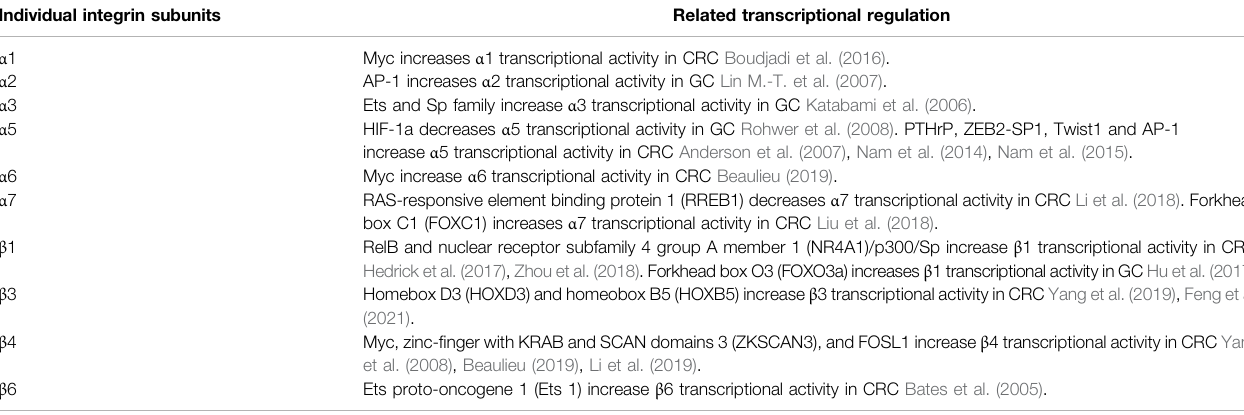
TABLE 2 | Transcription factors involved in the regulation of integrin subunits in GC and CRC. Individual integrin subunits Related transcriptional